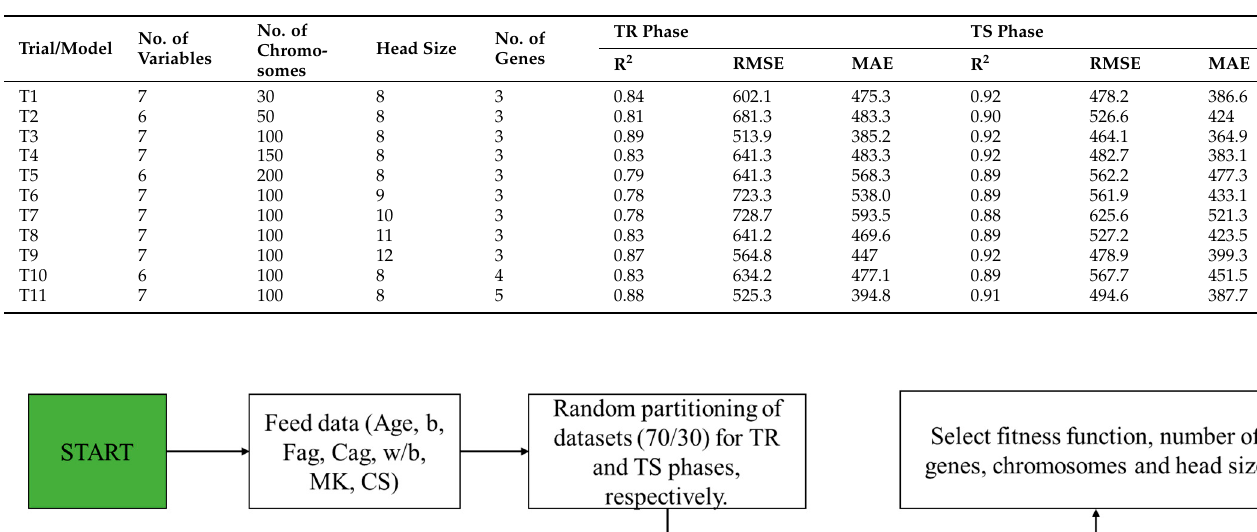
Table 2. Details of 11 GEP trials conducted for evaluating the most optimal model.